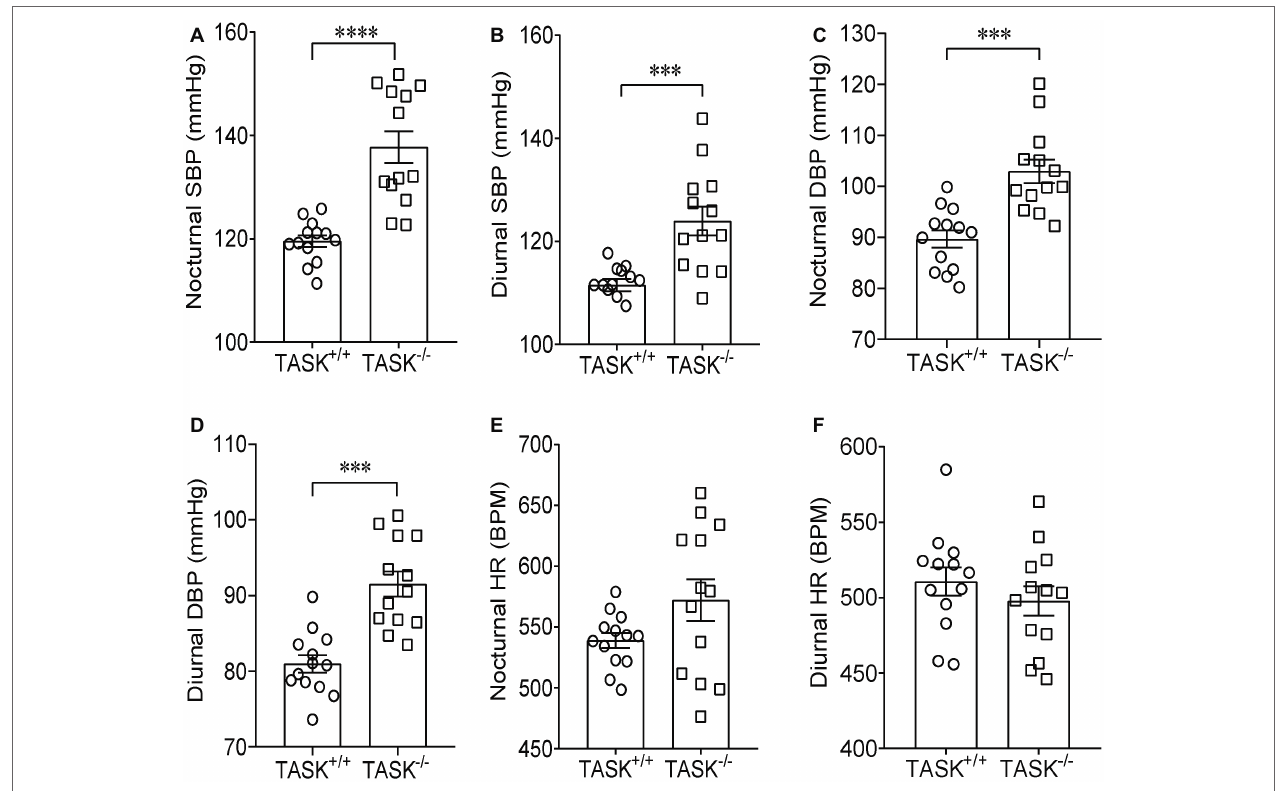
FIGURE 2 | Higher nocturnal and diurnal arterial pressure in TASK − / − mice. Telemetric recordings of arterial pressure and HR were made over 24 h in TASK +/+ and TASK − / − mice. Nocturnal BP and HR were calculated based on measurements made from 7 pm to 7 am, so 7 am to 7 pm for diurnal BP and HR. The average nocturnal SBP (A) and DBP (C) , diurnal SBP (B) and DBP (D) were higher in TASK − / − mice than control mice. The average nocturnal (E) and diurnal (F) HR was similar between two genotypes. n = 13 mice for each genotype, *** p < 0.001, **** p < 0.0001 as indicated by unpaired t